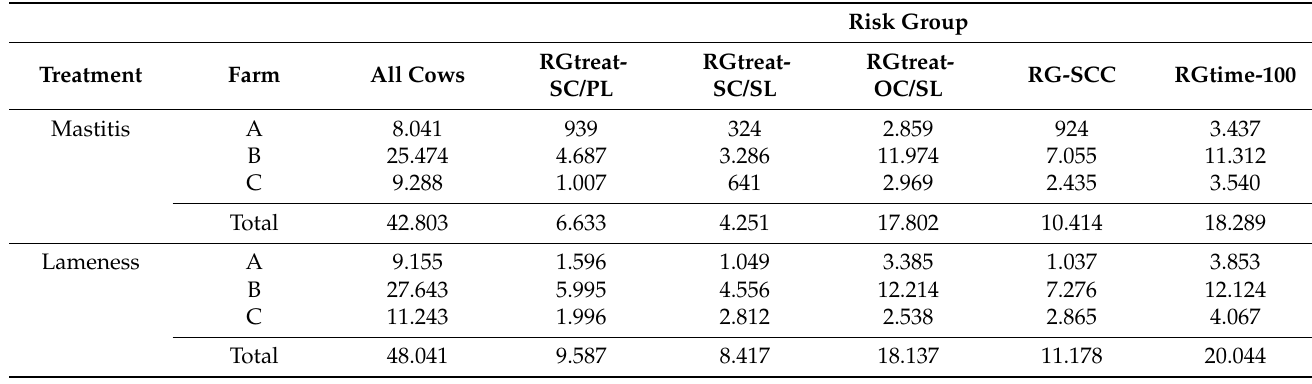
Table A3. The number of cow-days in the test data for all cows, as well as in the respective risk groups.